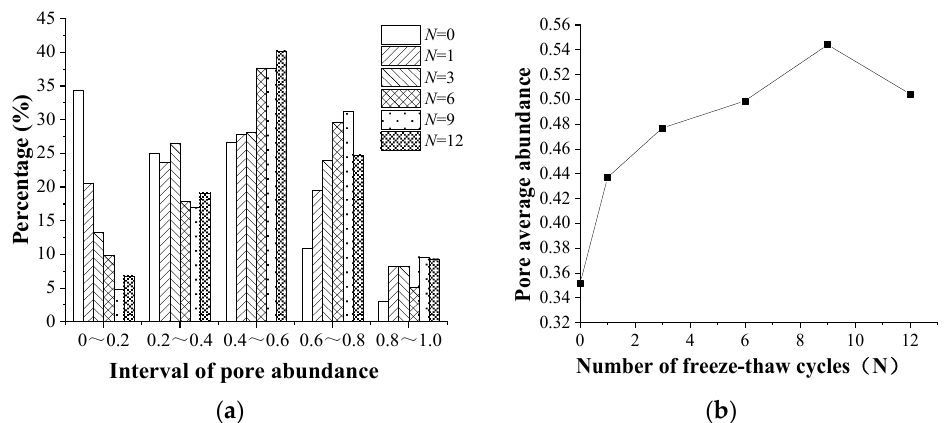
Figure 11. Pore abundance and average abundance under different freeze–thaw cycles. ( a ) Pore abundance. ( b ) Average abundance of pores.